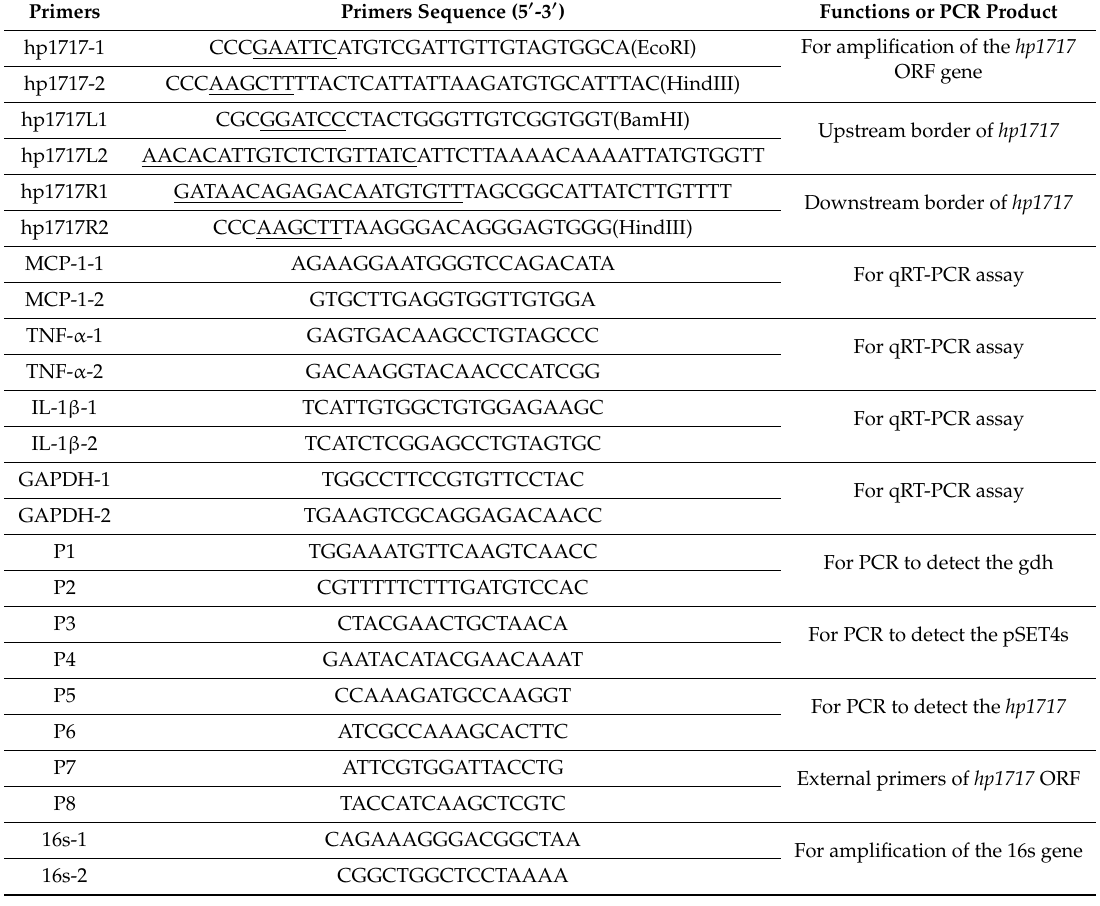
Table 2. Oligonucleotide primers used in this